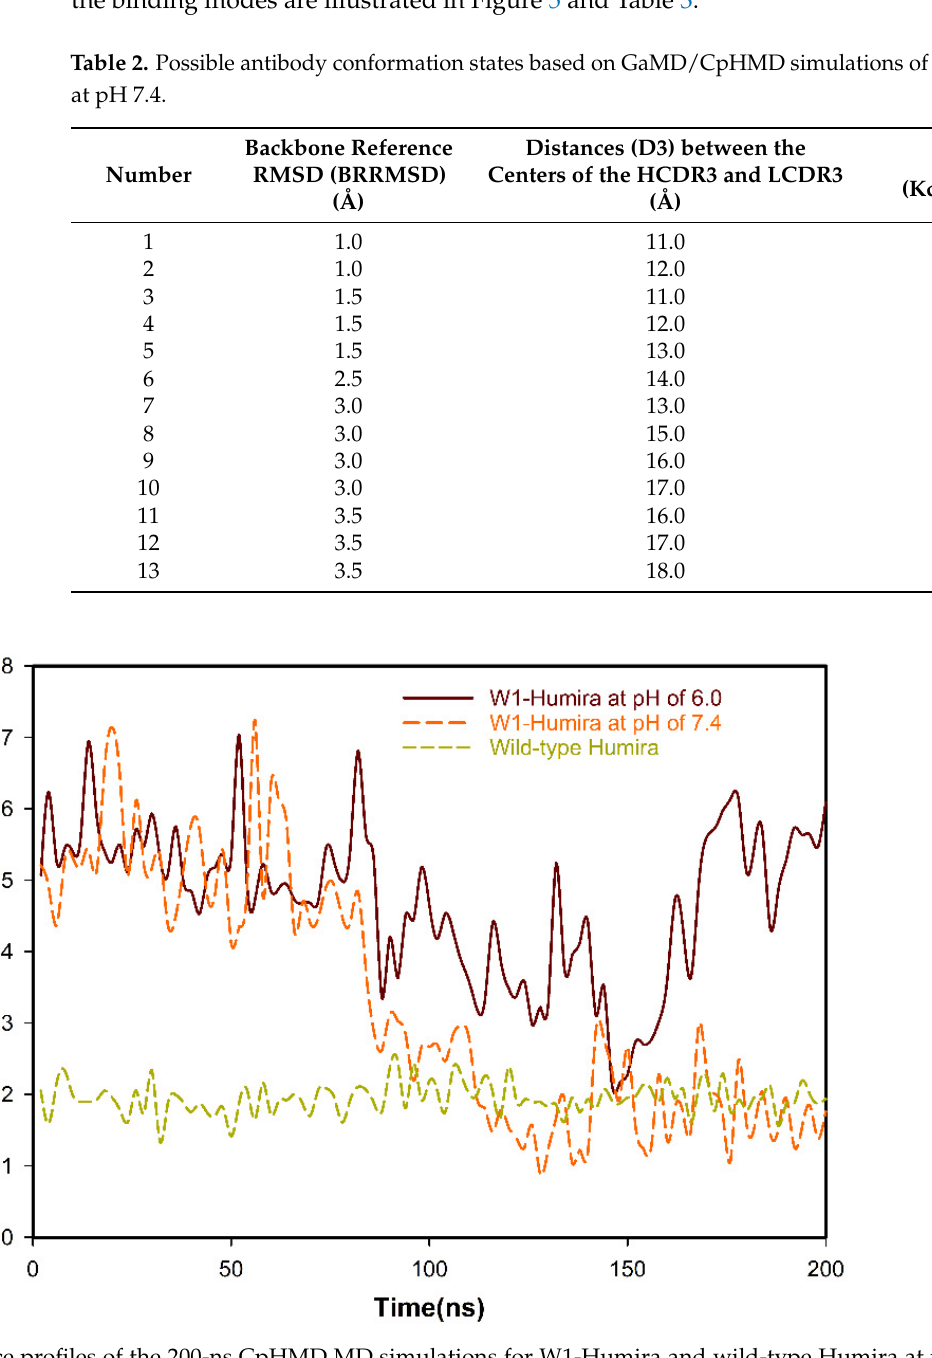
Figure 4. D3 distance profiles of the 200-ns CpHMD MD simulations for W1-Humira and wild-type Humira at pH 6.0 and 7.4.